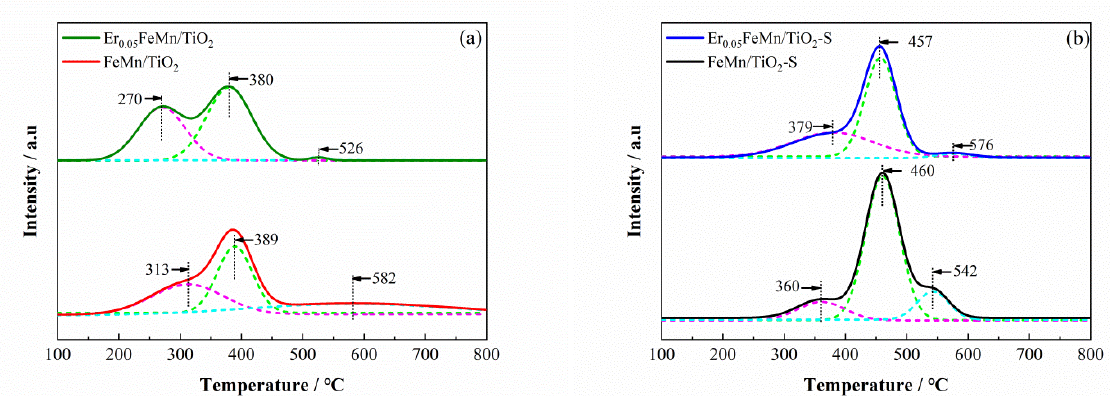
Figure 4. H 2 -TPR profiles of the fresh ( a ) and used ( b ) FeMn/TiO 2 and Er 0.05 FeMn/TiO 2 catalysts. After SO 2 resistance tests, the reduction peaks of the used catalysts shifted toward a higher temperature zone. As shown in Figure 4b, there were three reduction peaks in the profiles of these two kinds of catalysts. Their strongest peaks were centered at 457 º C and 460 °C, respectively, which were related to the reduction of sulfate species (Mn sulfates) [33]. The corresponding H 2 consumption value (151.6 cm 3 /g STP) for the strongest re- duction peak of Er 0.05 FeMn/TiO 2 -S catalyst was less than that (194.8 cm 3 /g STP) of FeMn/TiO 2 -S catalyst. It suggested that less amount of sulfate species had been formed on the surface of Er 0.05 FeMn/TiO 2 catalyst. The peaks centered at 379 and 360 °C could be assigned to the reduction of MnO 2 and Mn 2 O 3 [38], and the corresponding H 2 consump- tion value (39.3 cm 3 /g STP) for Er 0.05 FeMn/TiO 2 -S catalyst was much more than that (24.1 cm 3 /g STP) of FeMn/TiO 2 -S catalyst. It indicated that Er modification was favorable to maintain the redox ability of FeMn/TiO 2 catalyst when SO 2 coexisted in feeding gas. It was possible that Er modification on FeMn/TiO 2 catalyst could alleviate the deactivation due to the reaction between active species and SO 2 , thus inhibiting the formation of Mn sulfate species on the catalyst surface. 2.5. XPS Analysis The surface compositions and elementary oxidation states of the fresh and used catalysts (FeMn/TiO 2 and Er 0.05 FeMn/TiO 2 ) were analyzed by X-ray photoelectron spec- trometer (XPS). The spectra of Mn 2 p , O 1 s and S 2 p are shown in Figure 5, and the anal- ysis results of surface atomic concentration ratios are presented in Table S3. As shown in Figure 5a, two main peaks assigned to Mn 2 p 3/2 and Mn 2 p 1/2 were observed in the spectra of the catalysts. The overlapping peaks of Mn 2 p 3/2 could be divided into several sub-peaks with Shirley-type background. The obtained peaks could be ascribed to Mn 2+ (640.9–641.7 eV), Mn 3+ (642.0–643.0 eV) and Mn 4+ (643.3–644.5 eV), respectively [37]. The atomic ratio of Mn 4+ to Mn n+ was decided according to the peak area. As shown in Table S3, the atomic ratios of Mn 4+ /Mn n+ for FeMn/TiO 2 and Er 0.05 FeMn/TiO 2 catalysts were 31.9% and 33.9%, respectively. It suggested that more surface Mn 4+ species were gener- ated with the introduction of Er. This result was in accordance with the result of H 2 -TPR, in which the area of the reduction peak ascribed to MnO 2 to Mn 2 O 3 in the profile of Er 0.05 FeMn/TiO 2 catalyst was larger than that of FeMn/TiO 2 catalyst. Kapteijn et al. found that NO removal efficiency at low temperature for manganese oxides decreased in an order of MnO 2 > Mn 5 O 8 > Mn 2 O 3 > Mn 3 O 4 [43]. The high catalytic activity of MnO 2 (Mn 4+ ) was ascribed to its lattice defects [44]. Here, it could be inferred that the formation of more surface Mn 4+ species was conducive for achieving a high NO x conversion efficiency over Er 0.05 FeMn/TiO 2 catalyst, as shown in Figure 1a. Compared with the fresh FeMn/TiO 2 and Er 0.05 FeMn/TiO 2 catalysts, the peaks of Mn 2p 3/2 for the used catalysts were shifted toward higher binding energy (from 641.8 and 642.1 to 642.3 and 642.5 eV,